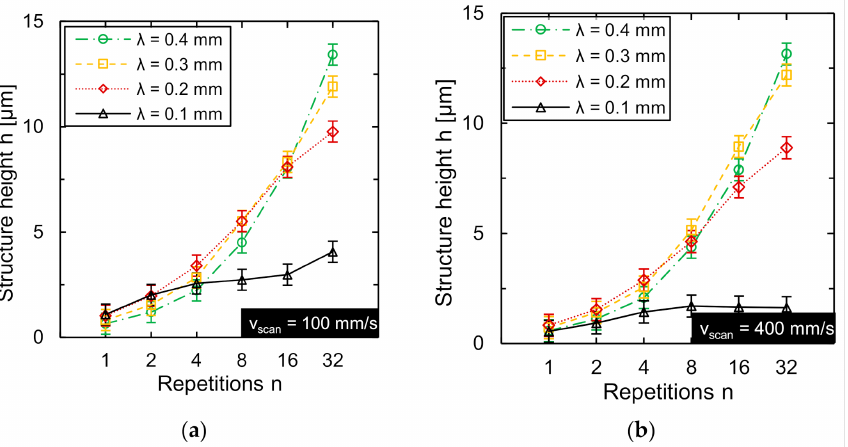
Figure 9. Structure height h as function of repetitions n for four different wavelengths at scan speeds of ( a ) v scan = 100 mm/s and ( b ) v scan = 400 mm/s ( d L = 50 µ m, P M and P A adapted to v scan